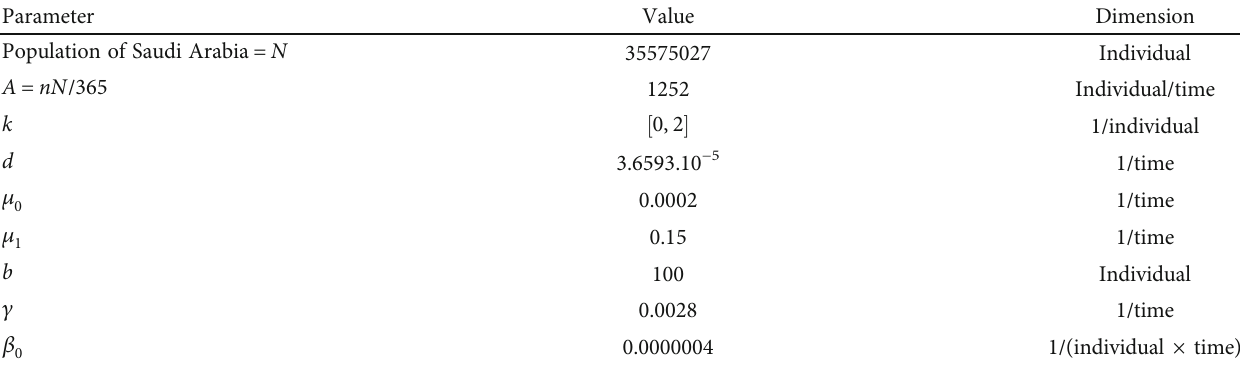
Table 2: Random parameters used in the numerical simulations for the real data of Saudi Arabia.